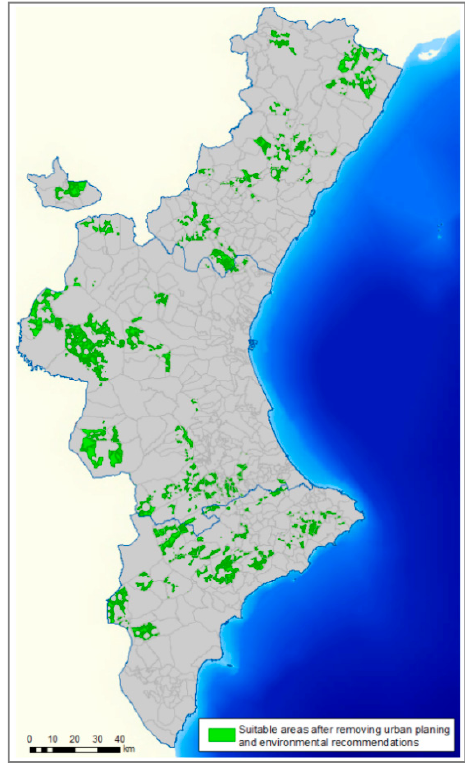
Figure 8. Suitable areas for siting pig farms in the VC in STEP 2. Table 7. The aggregated weights from experts’ judgements by AHP for factors and criterion.